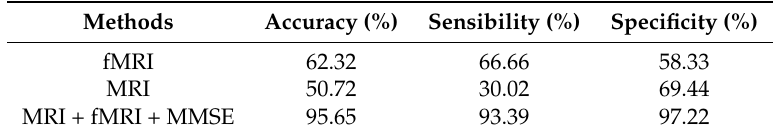
Table 5. Comparison of different SVM classifiers’ performance for diverse diagnostic data.